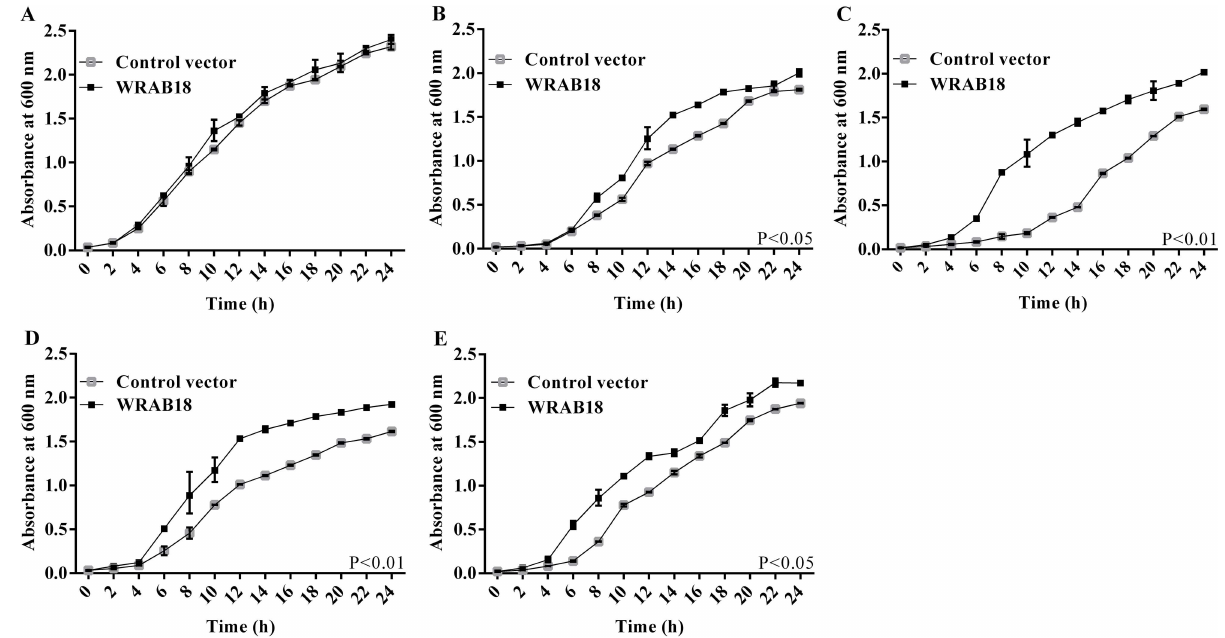
Fig 1. Growth curves of Escherichia coli cultures transformedwith WRAB18 or control pET28a under four abiotic stresses. E . coli strains grown under standard culture conditions (A) , in medium supplemented with 800 mM mannitol (B) or 500 mM NaCl (C) , and under exposure to 28˚ C (D) or 45˚ C (E) . The OD 600 was measuredas an indicatorof the increase in density of the liquidcultures. Each stress assay was performed three times, and statistically significantdifferences were analyzedusing the Student’s t-test. doi:10.1371/journal.pone.0171340.g001 PLOS ONE | DOI:10.1371/journal.pone.0171340 February 16,